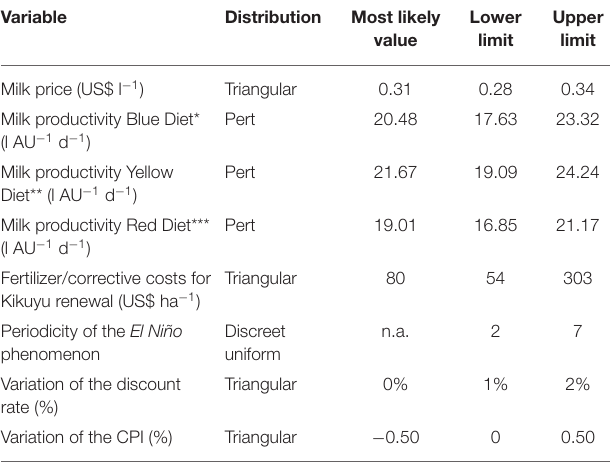
TABLE 3 | Variables simulated in the Monte Carlo